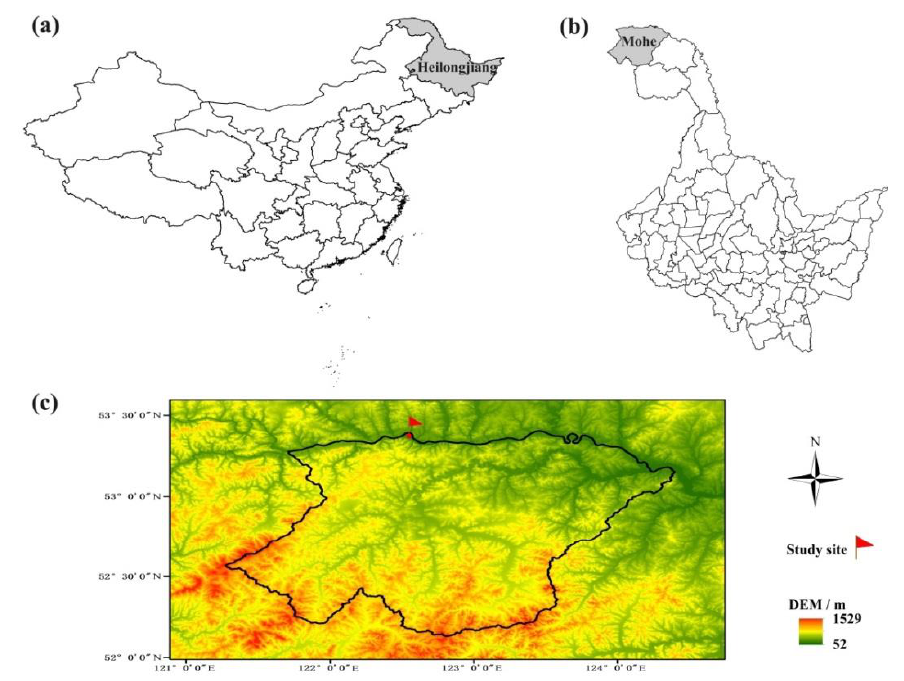
Figure1. LocationofstudysiteinMohe( c ), Heilongjiangprovince( b ), China( a )andtheDigitalElevation- Figure 1. Location of study site in Mohe ( c ), Heilongjiang province ( b ), China ( a ) and the Model (DEM) of Mohe ( c ). DigitalElevation-Model (DEM) of Mohe ( c ).